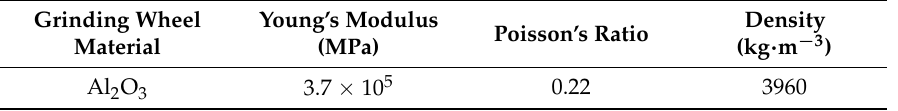
Table 4. Main physical property parameters of the grinding wheel